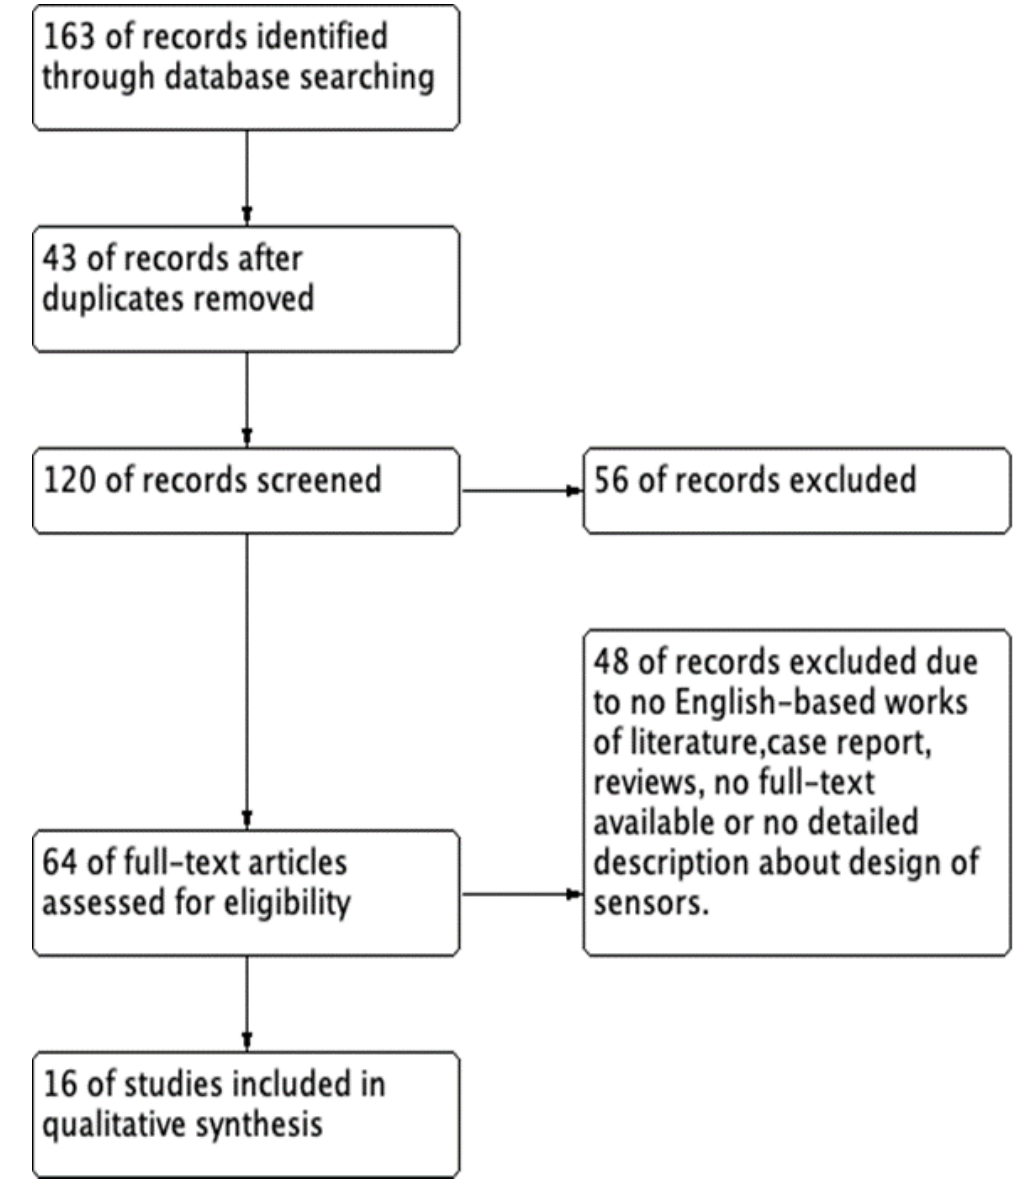
Figure 2. The flow diagram of this systematic review.